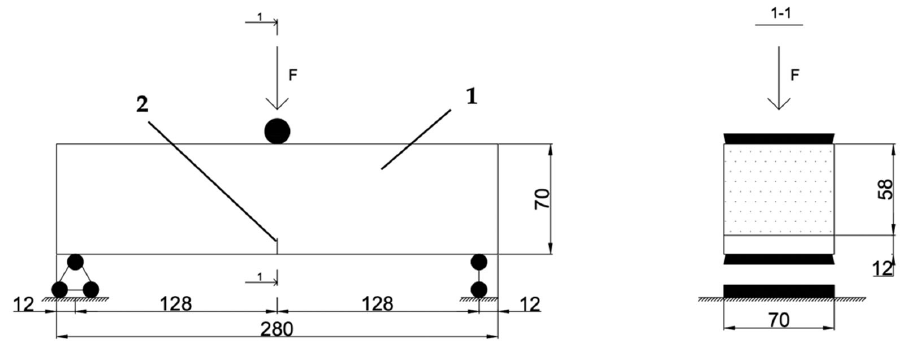
Figure 10. Scheme of determining the residual tensile strength of specimens: (1) sample and (2) incision.